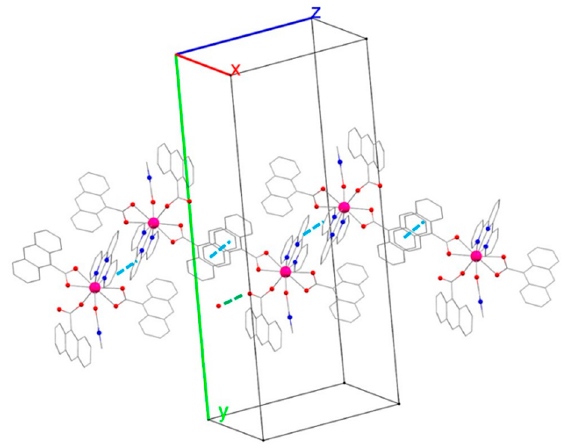
Figure 2. Hydrogen bond (green dashed line) and π – π stacking (blue dashed lines) in 1Eu .